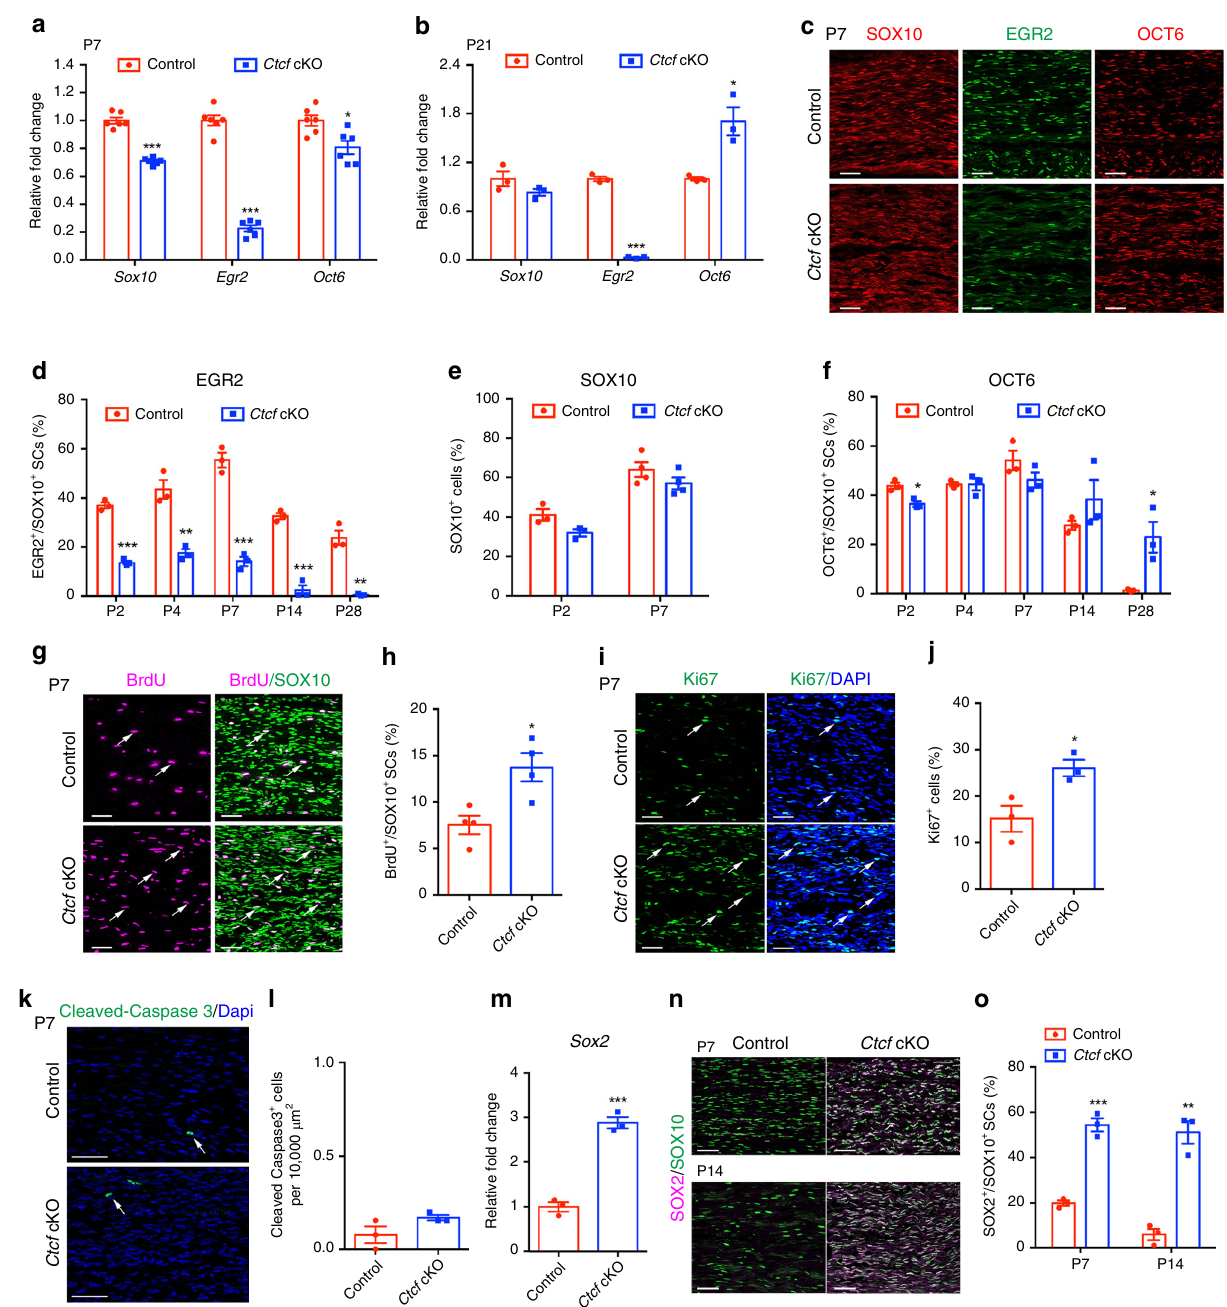
Fig. 4 CTCF deletion in SCs inhibits SC differentiation and myelination. a , b qRT-PCR analysis of promyelinating transcriptional regulators in control and Ctcf cKO mice sciatic nerves at a P7 and b P21. n = 6 animals/genotype for P7 and n = 3 animals/genotype for P21, a P ( Sox10 ) = 3.03E-07, P ( Egr2 ) = 6.92E- 09, P ( Oct6 ) = 0.0105; b P ( Sox10 ) = 0.171, P ( Egr2 ) = 4.97E-06, P ( Oct6 ) = 0.0152. c Immunolabeling of SOX10, EGR2, and OCT6 in P7 control and Ctcf cKO sciatic nerves ( n = 3 animals/genotype). Scale bars: 50 μ m. d – f Quanti fi cation of d EGR2 + /SOX10 + cells, e SOX10 + cells, and f OCT6 + /SOX10 + cells at different stages. n = 4 animals/genotype for SOX10 at P7, n = 3 animals/genotype for others, d P (P2) = 7.27E-05, P (P4) = 0.00331, P (P7) = 0.000294, P (P14) = 0.00023, P (P28) = 0.00126; e P (P2) = 0.056, P (P7) = 0.20; f P (P2) = 0.011, P (P4) = 0.99, P (P7) = 0.18, P (P14) = 0.27, P (P28) = 0.026. g Immunolabeling and h analysis of BrdU and SOX10 in P7 control and Ctcf cKO sciatic nerves. Arrows indicate SOX10 + /BrdU + SCs. Scale bars: 50 μ m. n = 4 animals/genotype, P = 0.014. i Immunolabeling and j quanti fi cation of Ki67 in P7 control and Ctcf cKO sciatic nerves. Arrows indicate Ki67 + cells. Scale bars: 50 μ m. n = 3 animals/genotype, P = 0.03. k Immunolabeling and l quanti fi cation of cleaved-caspase 3 in P7 control and Ctcf cKO sciatic nerves. Arrows indicate Cleaved-Caspase 3 + SCs. Scale bars: 100 μ m. n = 3 animals/genotype, P = 0.12. m qPCR analysis of Sox2 in P7 control and Ctcf cKO sciatic nerves. n = 3 animals/genotype, P = 0.00032. n , o Immunolabeling ( n ) and quanti fi cation of SOX2 and SOX10 ( o ) in P7 and P14 control and Ctcf cKO sciatic nerves. Scale bars: 50 μ m. n = 3 animals/genotype, P (P7) = 0.0004, P (P14) = 0.0013. Data are presented as means ± SEM., * P < 0.05, ** P < 0.01, *** P < 0.001, two- tailed unpaired Student ’ s t -test. Source data are provided as a Source Data fi